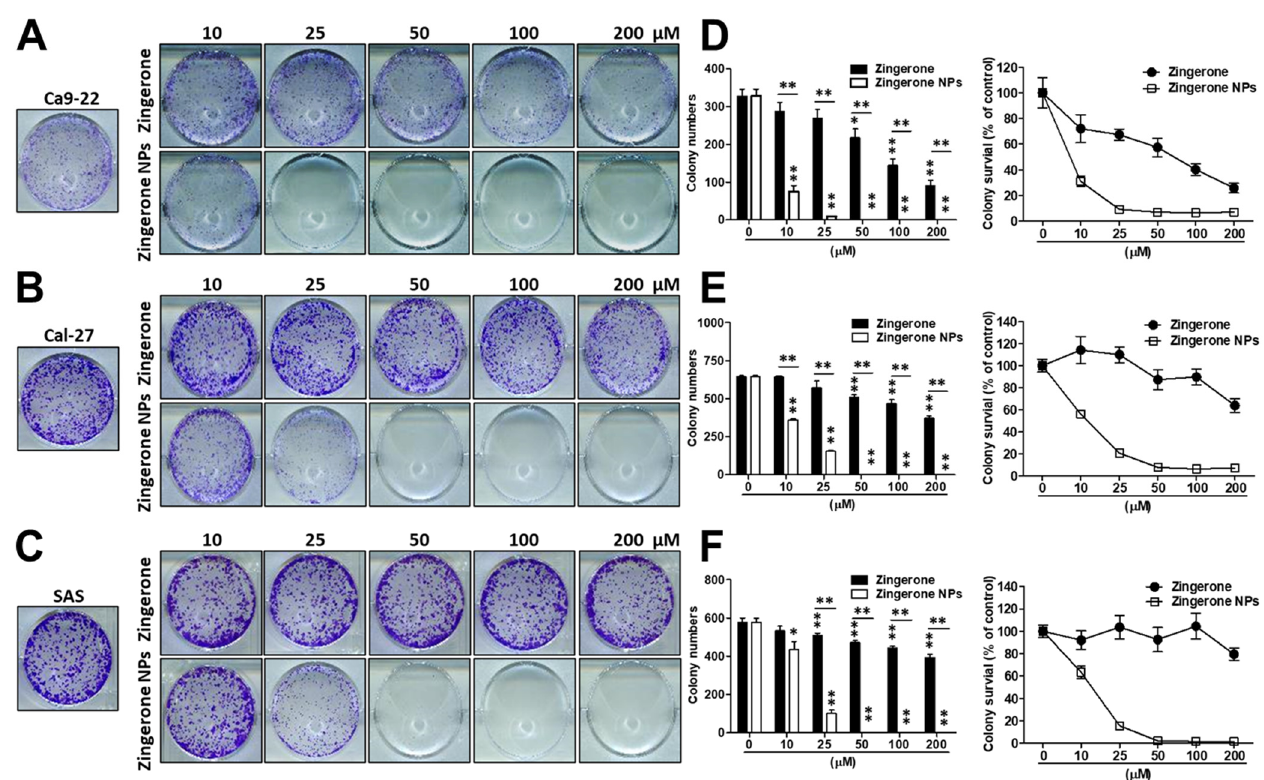
Figure 2. Zingerone NPs elicited a superior anti-tumorigenicity in three human OSCC Ca9-22, Cal-27, and SAS cell lines in vitro. Cells were treated with various doses of zingerone and/or zingerone NPs for 7–10 days. The colony formation was further stained and detected using crystal violet staining. The zingerone NP-mediated anti-tumorgenicity on Ca9-22 cells ( A ), Ca1-27 cells ( B ), and SAS cells ( C ) was observed and recorded using inverted microscopy. Quantitative analysis of colony formation was performed, and either colony numbers or colony survival rate for ( D ) Ca9-22 cells, ( E ) Ca1-27 cells, and ( F ) SAS cells, respectively, were further counted and determined using absorbance detection at 595 nm. All data are expressed as the mean ± SEM of three experiments. * p < 0.05, ** p < 0.01.